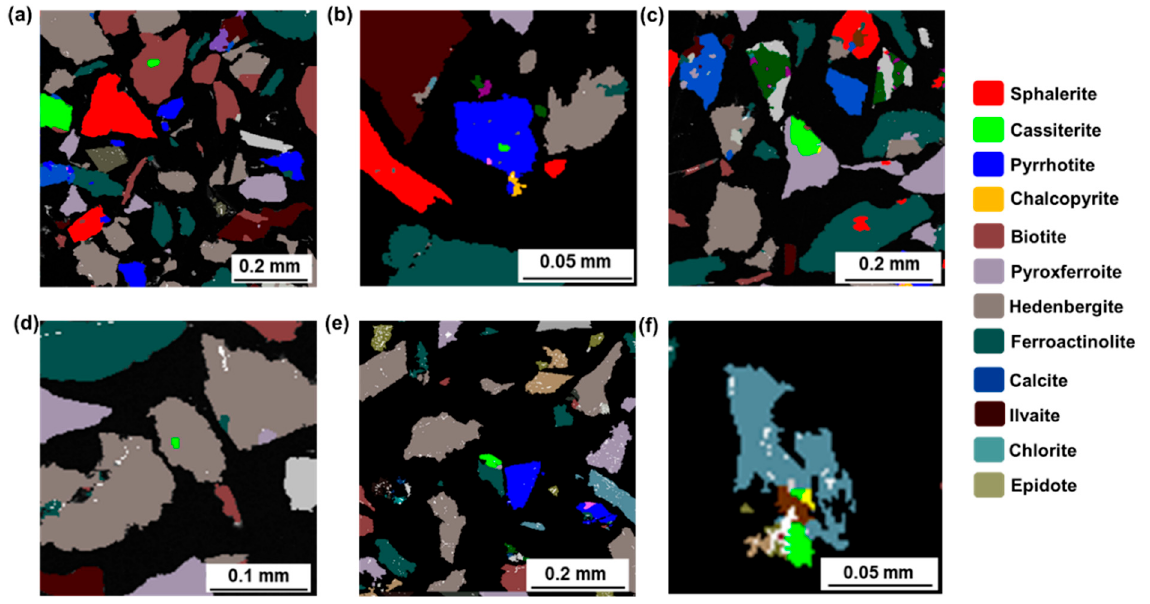
Figure 4. ( a ) Association of cassiterite and biotite in raw ore; ( b ) Association of cassiterite and pyrrhotite in raw ore; ( c ) Association of cassiterite and pyroxferroite in raw ore; ( d ) Association of cassiterite and hedenbergite in raw ore; ( e ) Association of cassiterite and ferroactinolite in pebble; ( f ) Association of cassiterite and chlorite in pebble.